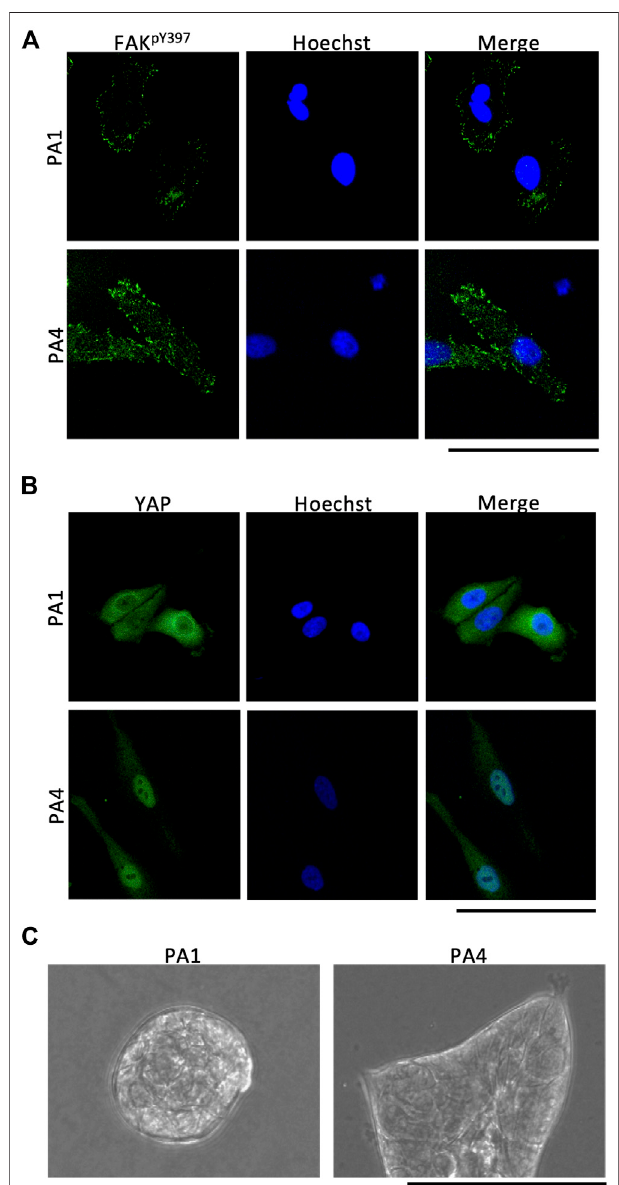
FIGURE 6 | Immunostaining and Matrigel overlay culture of PA gels containingNHS-AAester. (A) Focaladhesionsstainedwith p -FAKincreasedmore insizeandnumberonstiffgels (bottom) thanonsoftgels (top) .Scalebar:100 µm (B) YAPprotein in MCF10A cells waslocalized in thecytoplasm on soft gels (top) and in the nucleus on stiff gels (bottom) . Scale bar: 100 µm. (C) In Matrigel overlay culture, MCF10A cells formed acini on soft gels and spread on stiff gels.